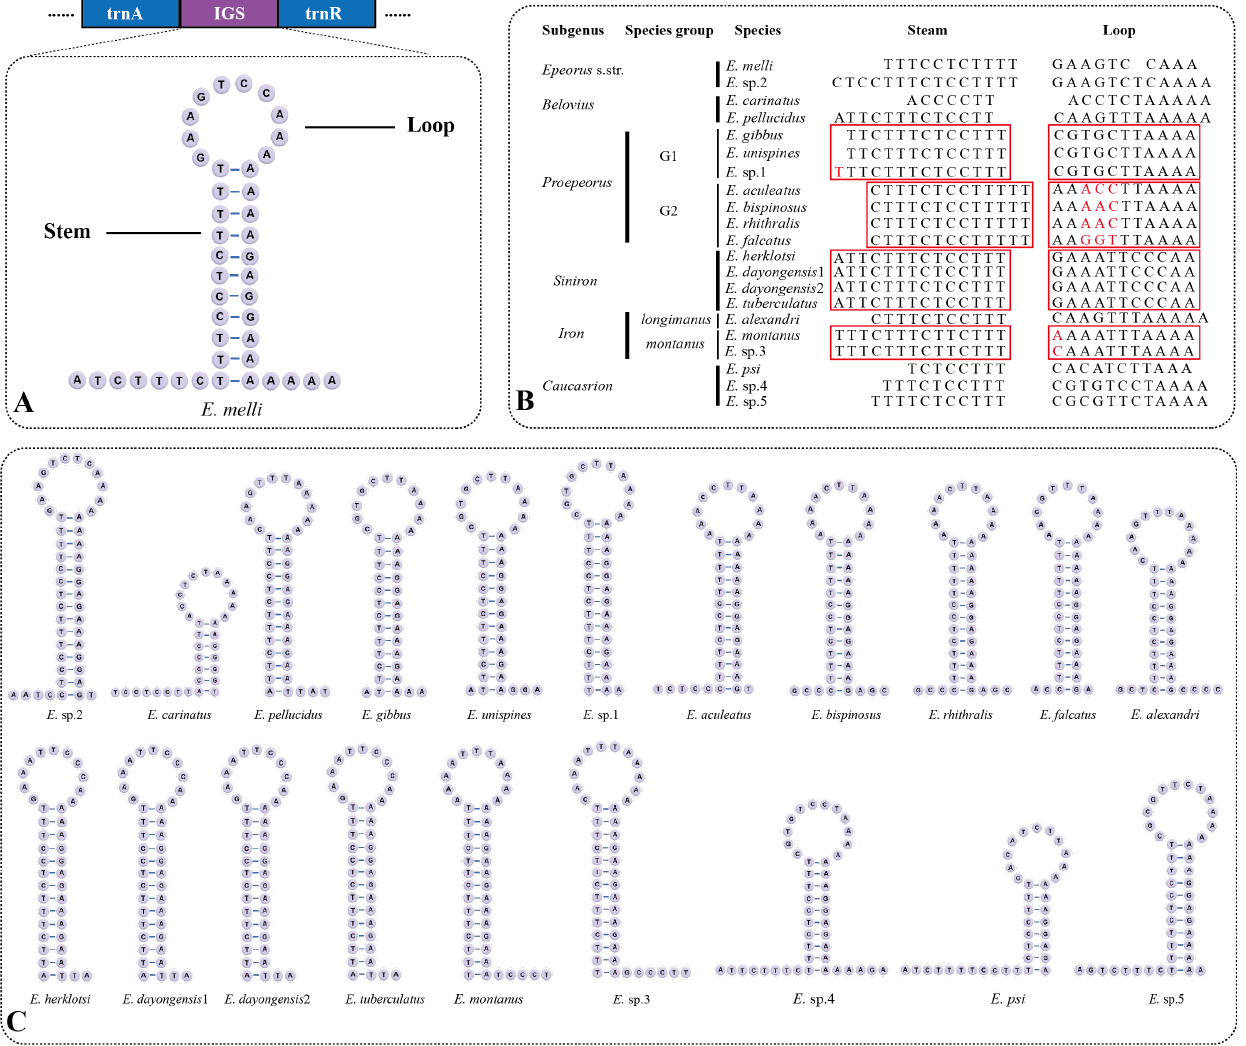
Figure 5. The intergenic spacers (IGS) between trnA and trnR in Epeorus mitogenomes: ( A ) The stem-loop structure; and the ( B ) alignment of the sequences for stems and loops among 21 Epeorus mitogenomes. The conserved sequences are in red boxes and the variable sites are shown in red. ( C ) The stem-loop structure of all IGS among 21 mitogenomes.